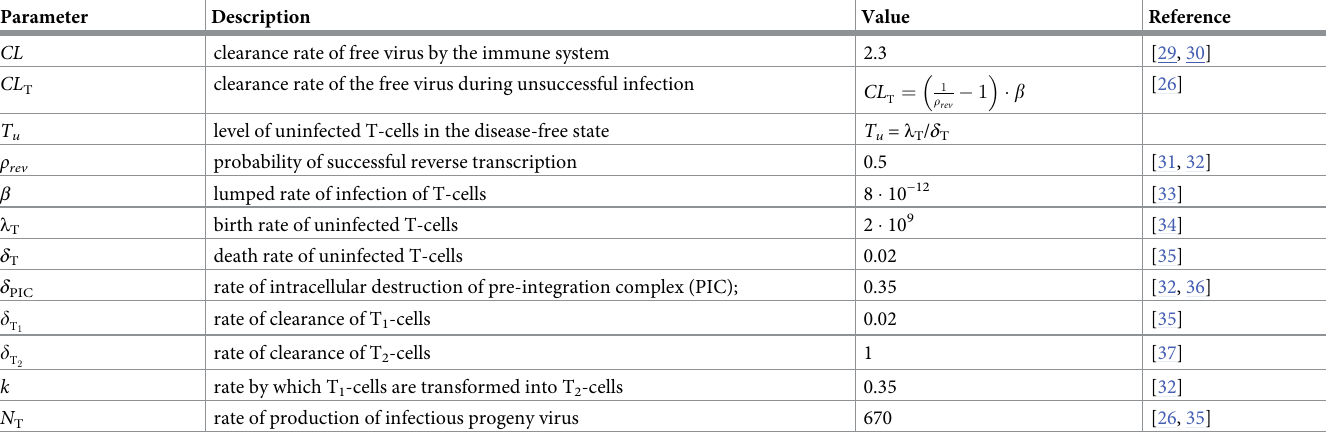
Table 1. Parameters for viral dynamics model. Parameter Description Value